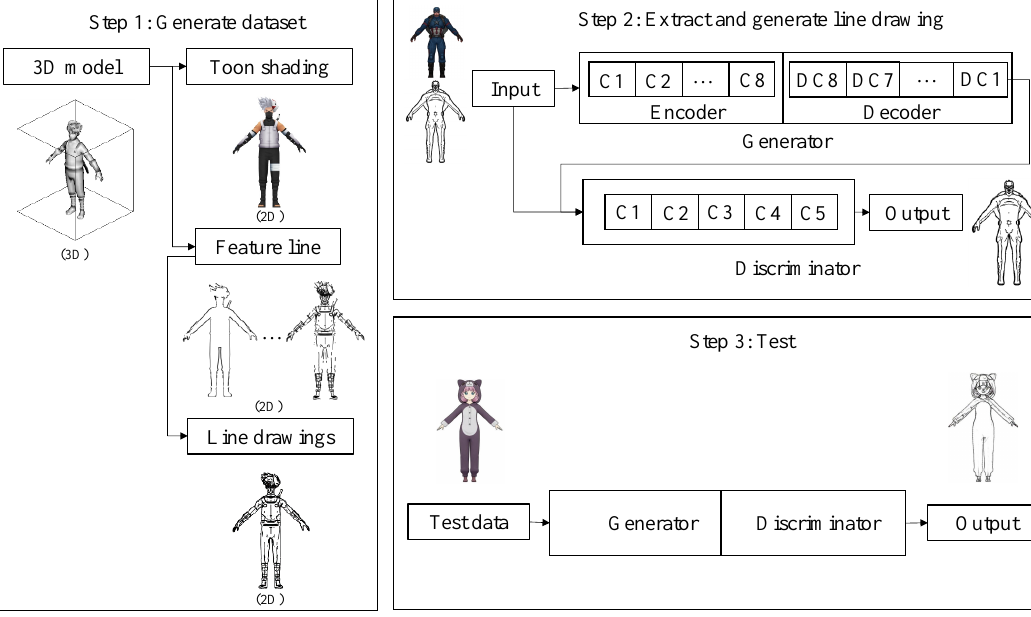
Figure 3. Structure of the proposed method.